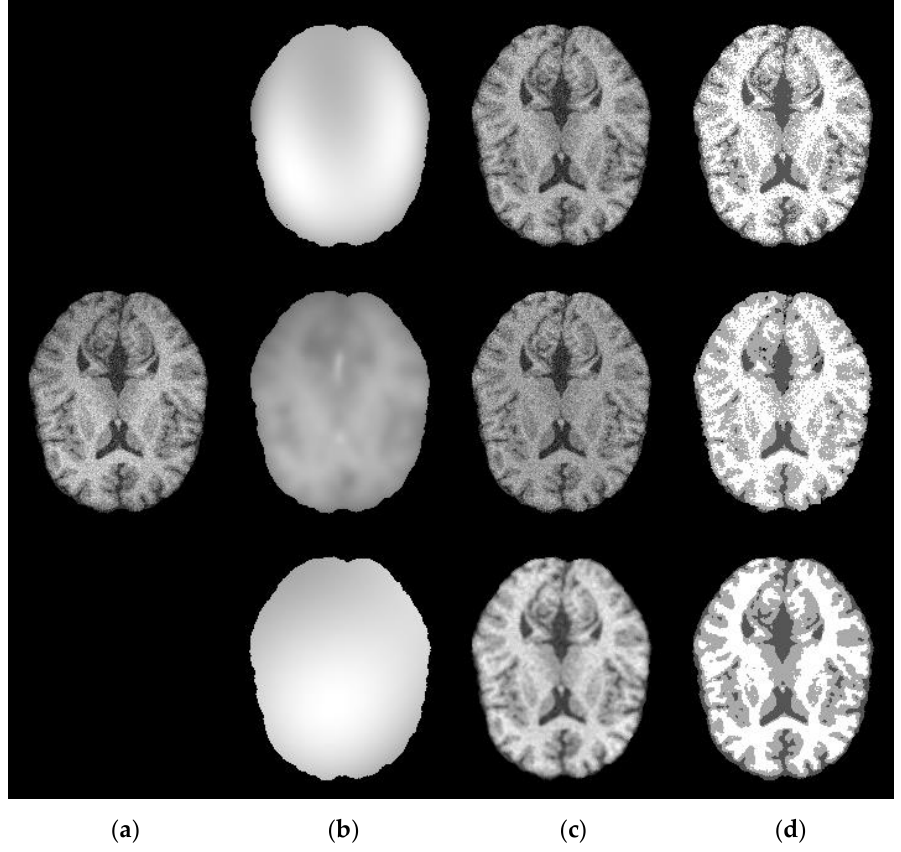
Figure 7. Comparison of the segmentation results of local intensity clustering (LIC), MICO, and RC_LCI: ( a ) original image; ( b ) estimated bias field; ( c ) bias field correction images; and ( d ) segmentation results. Table 2. JS of LIC, MICO, and RC_LCI.